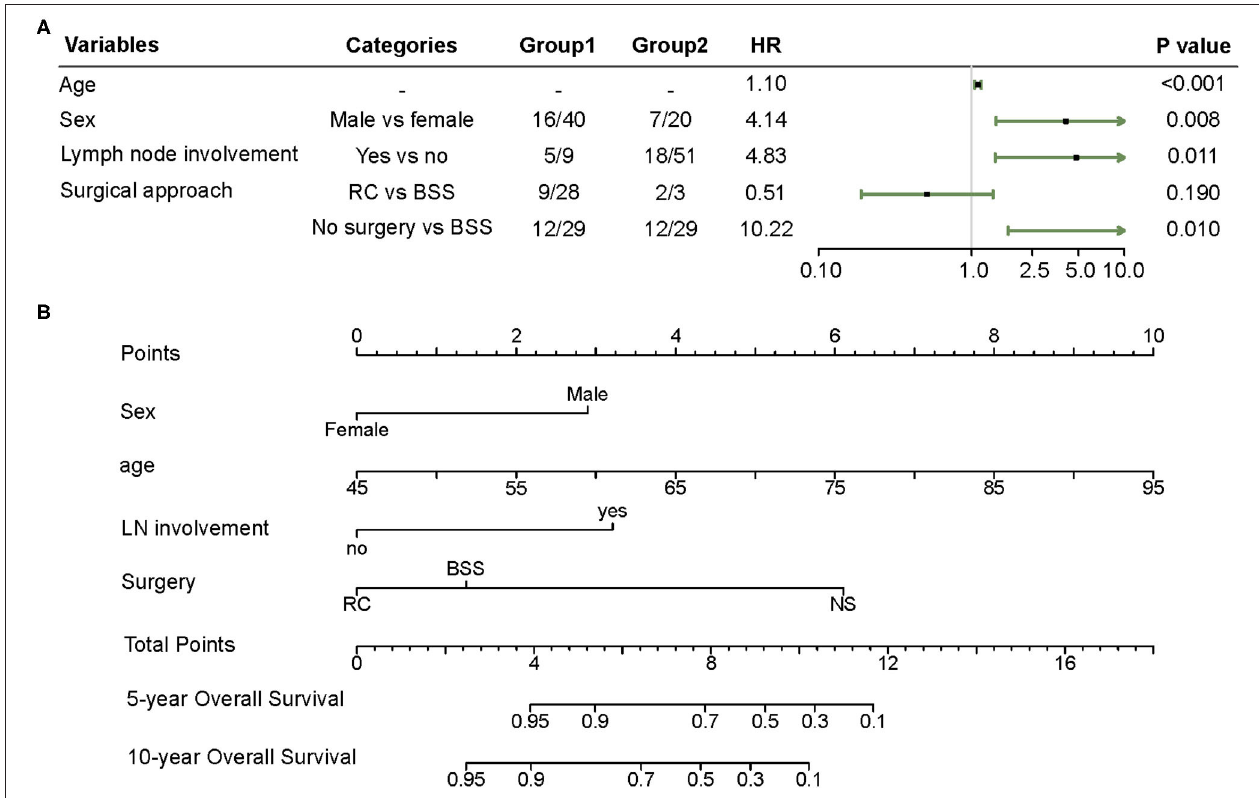
FIGURE 1 | (A) Forest plot of the multivariate Cox regression model obtained from the SEER cohort. (B) Nomogram predicting 5 and 10 year overall survival (OS) for patients with LELCB. Each variable value is assigned a point and the sum of points can be translated to predict the probability of OS by a line drawn downward on the probability axis. BSS, bladder-sparing surgery; LELCB, lymphoepithelioma-like carcinoma of the urinary bladder; LN, lymph node; NS, no surgery; RC, radical